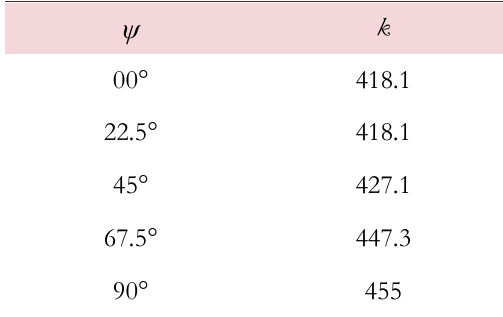
Table 3: Identification of the constant hardening law for fixed